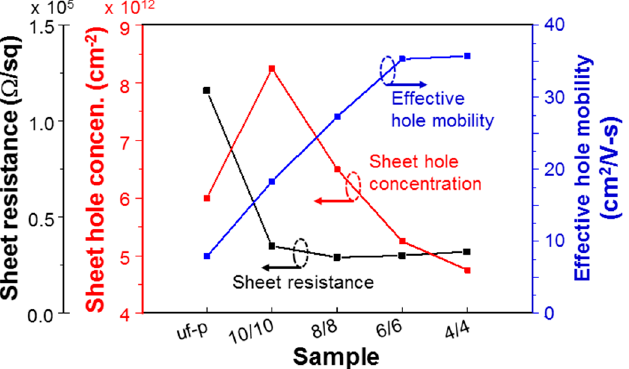
Figure 9. Variations of sheet resistance (with the first left ordinate), sheet hole concentration (with the second left ordinate), and effective hole mobility (with the right ordinate) of samples uf-p, 10/10, 8/8, 6/6, and 4/4.